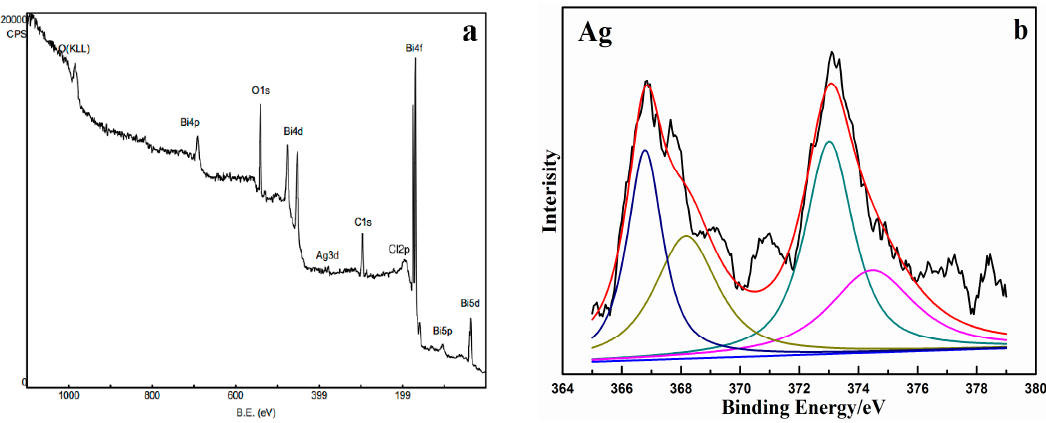
Figure 6. ( a ) XPS survey spectra of Ag@AgCl/Bi 2 O 2 CO 3 ; ( b ) High-resolution XPS spectra of Ag 3d.